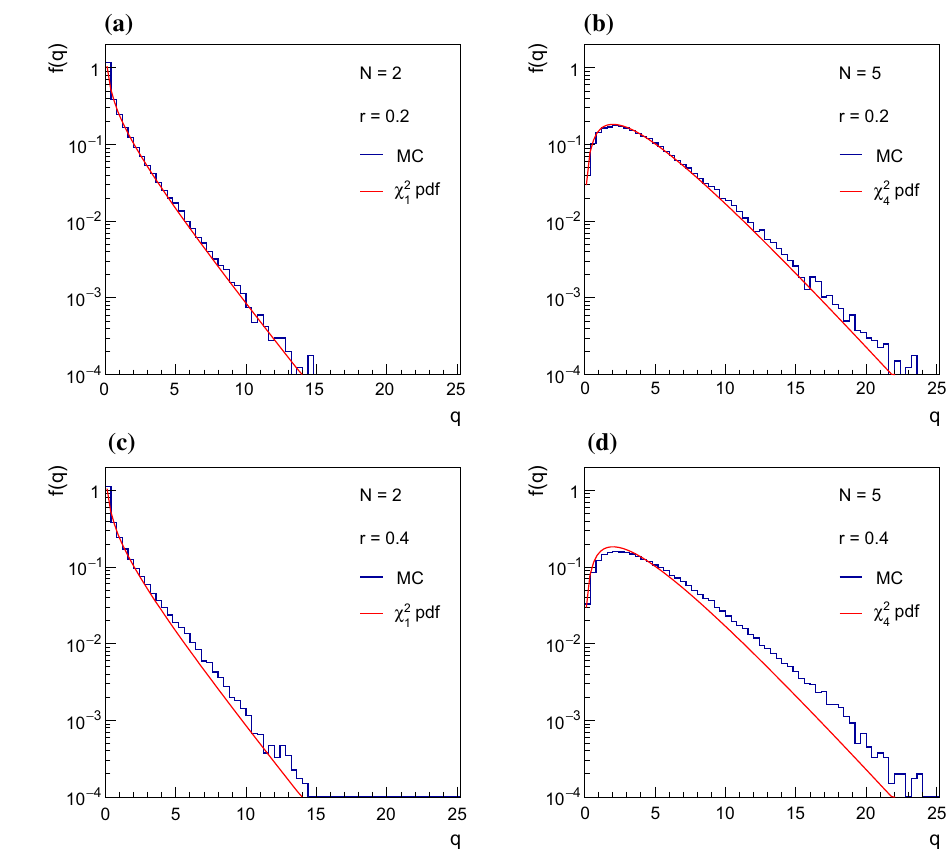
Fig. 5 Distributions of the test variable q for averages of N = 2 and 5 values using r = 0 . 2 and r = 0 .